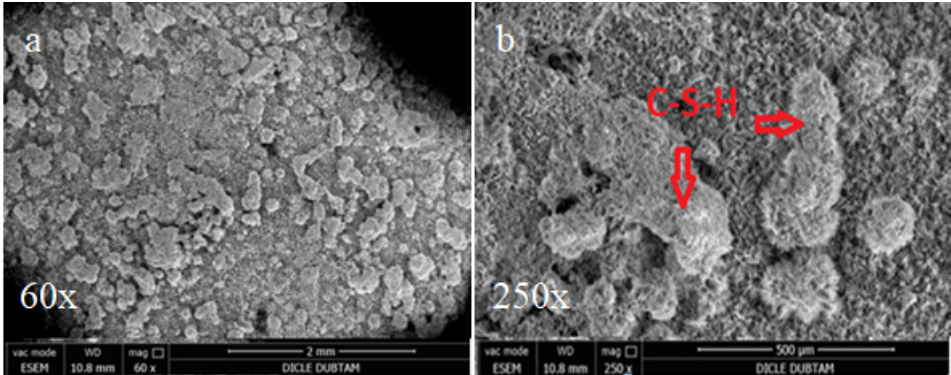
Figure 13. SEM images of FAS replacement bar samples cured 90 days in hydropath: ( a ) 60×; ( b ) 250×.